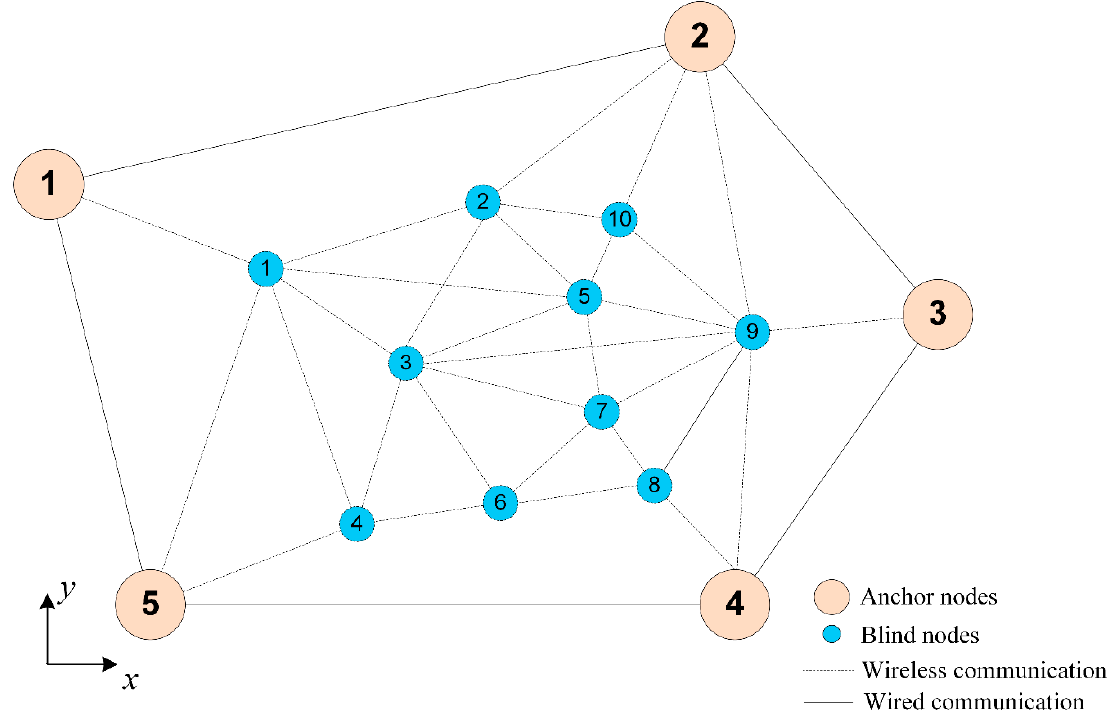
Figure 1. General scheme of a wireless sensor networks (WSN) represented by a graph.